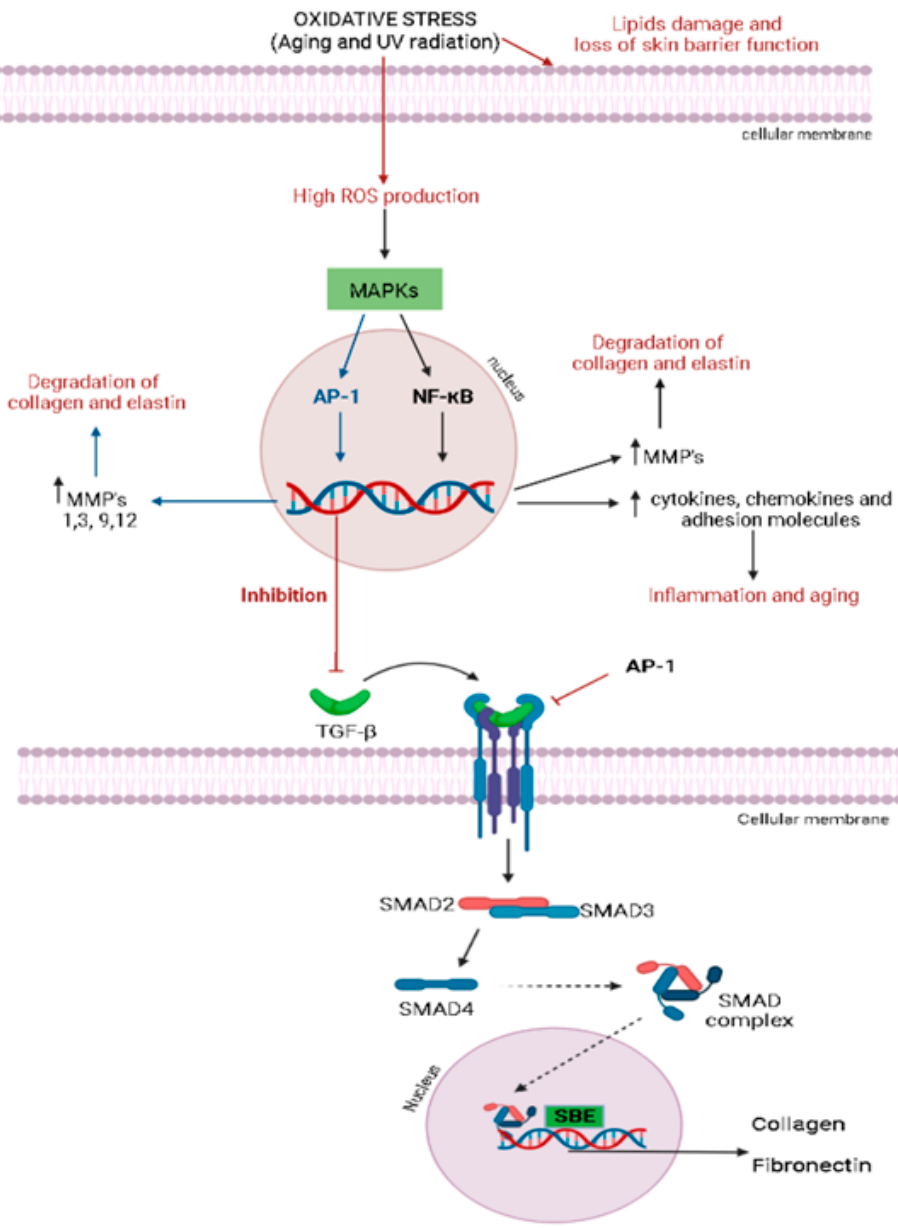
Figure 2. TGF- β signaling pathway. AP-1, factor activating protein 1; SBE, SMAD-binding elements; TGF- β , transforming growth factor beta; T β RI, TGF- β type I receptor; T β RII, TGF- β type II receptor. The illustration was drawn using BioRender software.